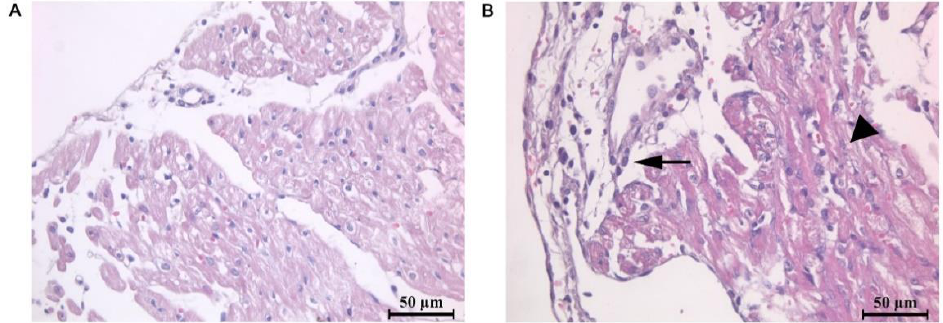
Figure 2. Representative microphotographs of the right atrium frontal section in control rats ( A ) and rats with the experimental model of pulmonary hypertension ( B ). Staining by hematoxylin and eosin (H&E). All images were obtained with 40 × magnification. Arrow indicates epicardium thickening, inflammatory cell infiltrates, and interstitial and perivascular edema, and the arrowhead points to the hypertrophic and damaged atrial